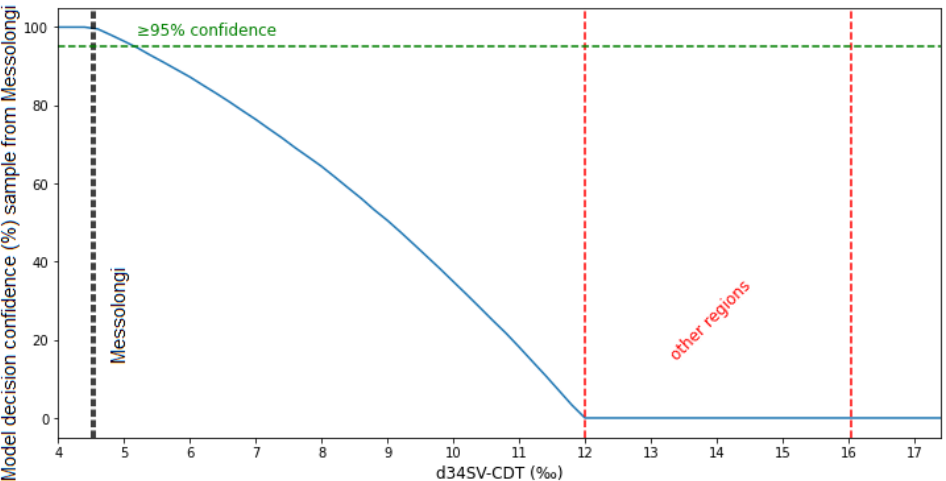
Figure 6. Decision confidence level of probabilistic model of a sample has been collected from